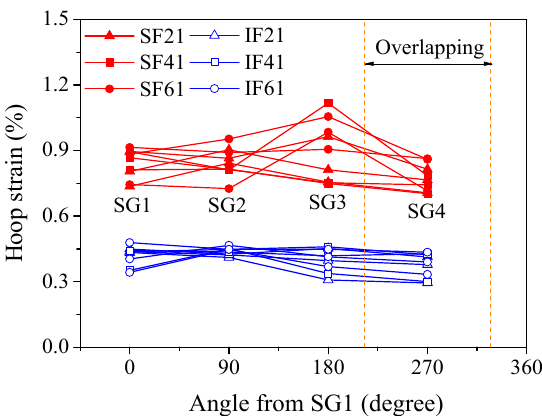
Figure 12. Distribution of hoop strains of FRP tubes in PIFFT and SIFFT specimens at peak loads.